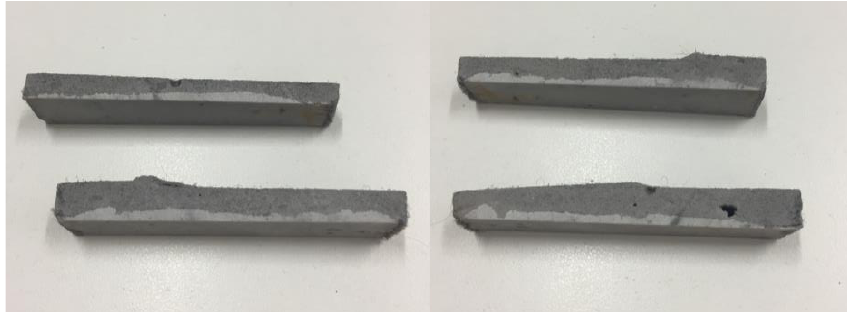
Figure 15. Nonuniform distribution of colloid thickness. Appl. Sci. 2019, 9, x FOR PEER REVIEW